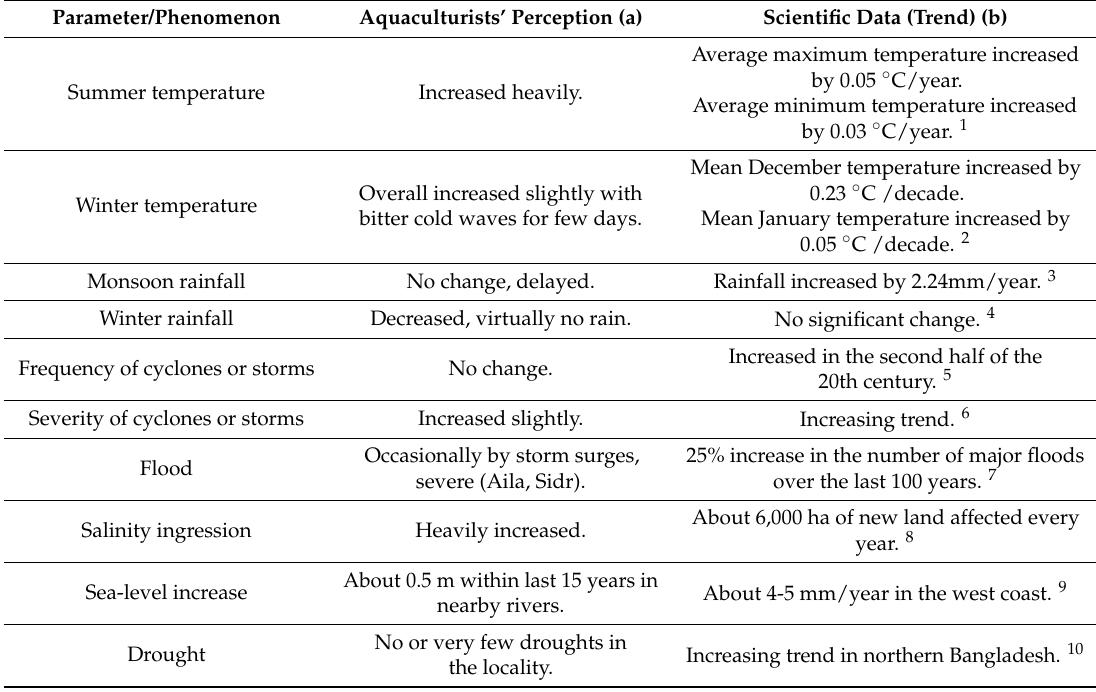
Table 2. Shrimp-farming community’s perception of climate